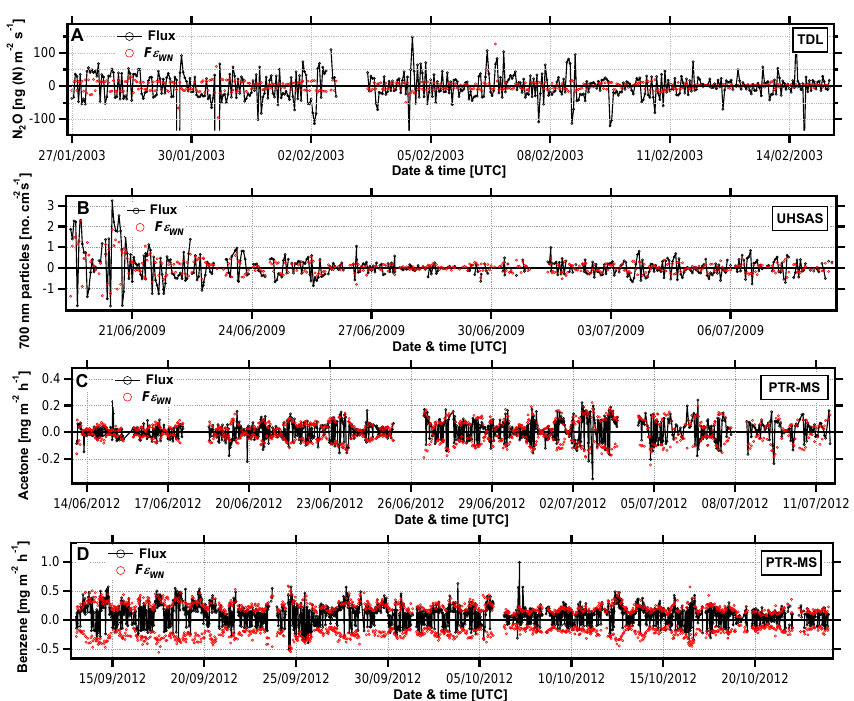
Figure 8. An example of “mirroring” in eddy-covariance data with low SNR processed with the MAX time-lag method. The data were obtained by TDL (panel a ), UHSAS (data from a single size bin – panel b ) and PTR-MS (panels c and d ) instruments during four separate measurement campaigns. Red circles show a flux calculated from a cross-covariance between a time series of Gaussian white noise ( ε WN ) and the vertical wind velocity ( w) . The standard deviation of the white noise was set to match that of the instrument noise for each of the analysers and the flux was determined by searching for a maximum in the